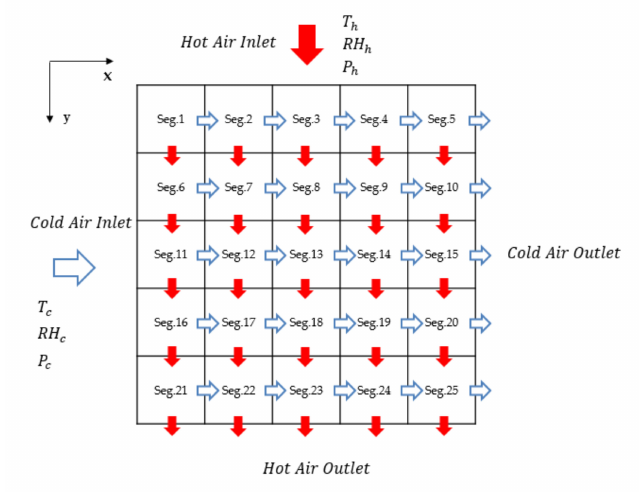
Figure 5. Schematic of the discretization in the segments divided into small control volumes for predicting the heat transfer rate and pressure drop across the plate-fin heat